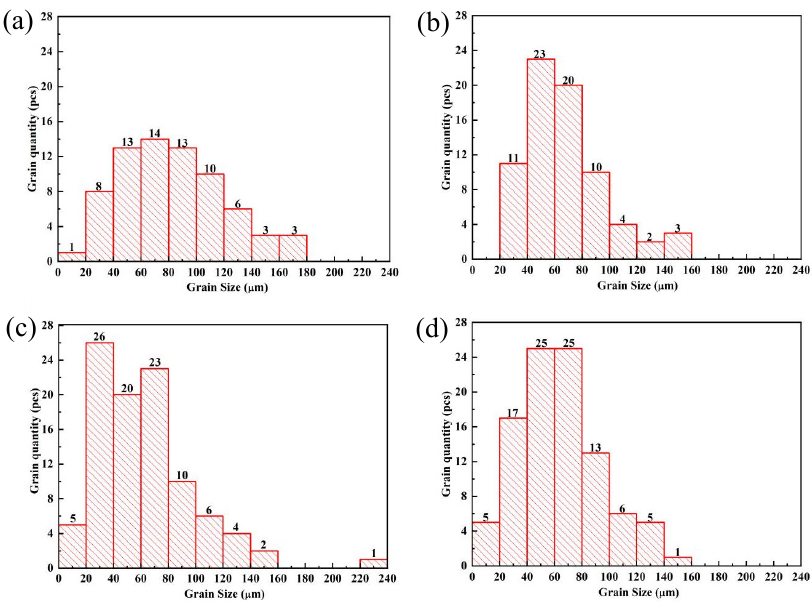
Figure 2. Histogram of the grain size distribution of ( a ) ZL205A alloy, ( b ) ZL205A + 0.1%La alloy, ( c ) ZL205A + 0.3%Al–5Ti–0.8C alloy, and ( d ) ZL205A + 0.1%La + 0.3%Al–5Ti–0.8C alloy. The average grain sizes are shown in Table 2. The average grain size of the ZL205A alloy was 82 μm. After adding Al–5Ti–0.8C and La, the average grain size decreased significantly— to 62 μm for the alloy with 0.3%Al–5Ti–0.8C, 68 μm for the alloy with 0.1%La, and 61 μm for the alloy with 0.1%La + 0.3%Al–5Ti–0.8C. The refining effect was equivalent to that of the Al–5Ti–0.8C master alloy, but better than that of La. Table 2. Grain size of ZL205A alloy with the addition of Al–5Ti–0.8C and La.